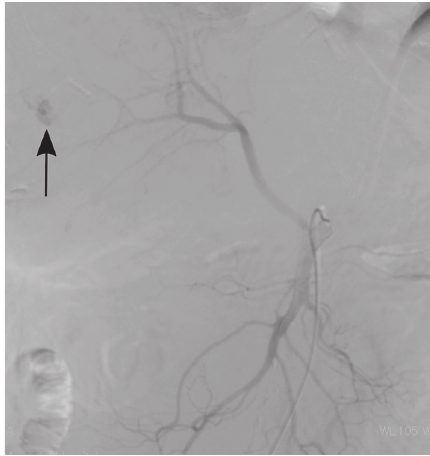
Figure 4: Pooling of contrast medium was observed on angiog- raphy (arrow). Right hepatic artery was replaced on the superior mesenteric artery.